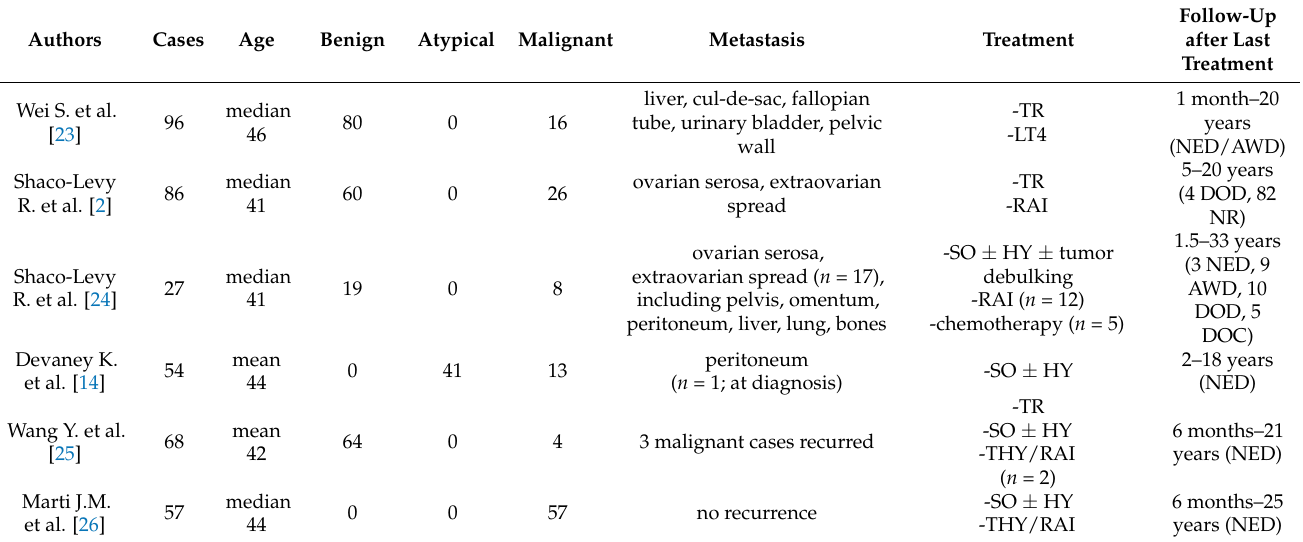
Table 1. Clinical cases of ovarian strumas: clinical course and morphological